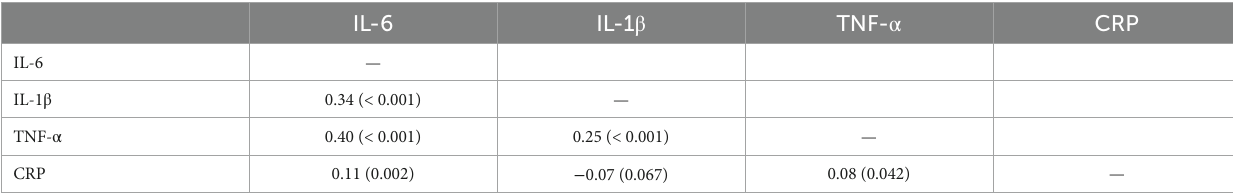
TABLE 2 Spearman’s correlation coefficients ( p -value) between the inflammatory